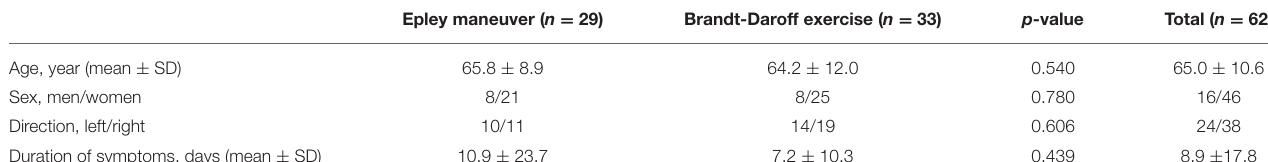
TABLE 1 | Comparison of clinical findings between Epley maneuver group and Brandt-Daroff exercise group.